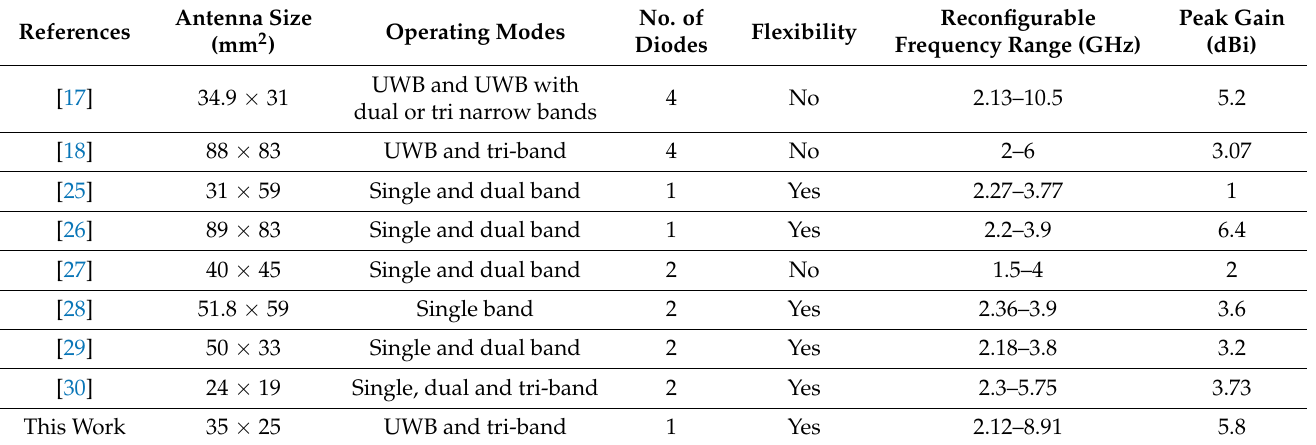
Table 1. Performance comparison of the proposed antenna with other frequency reconfigurable